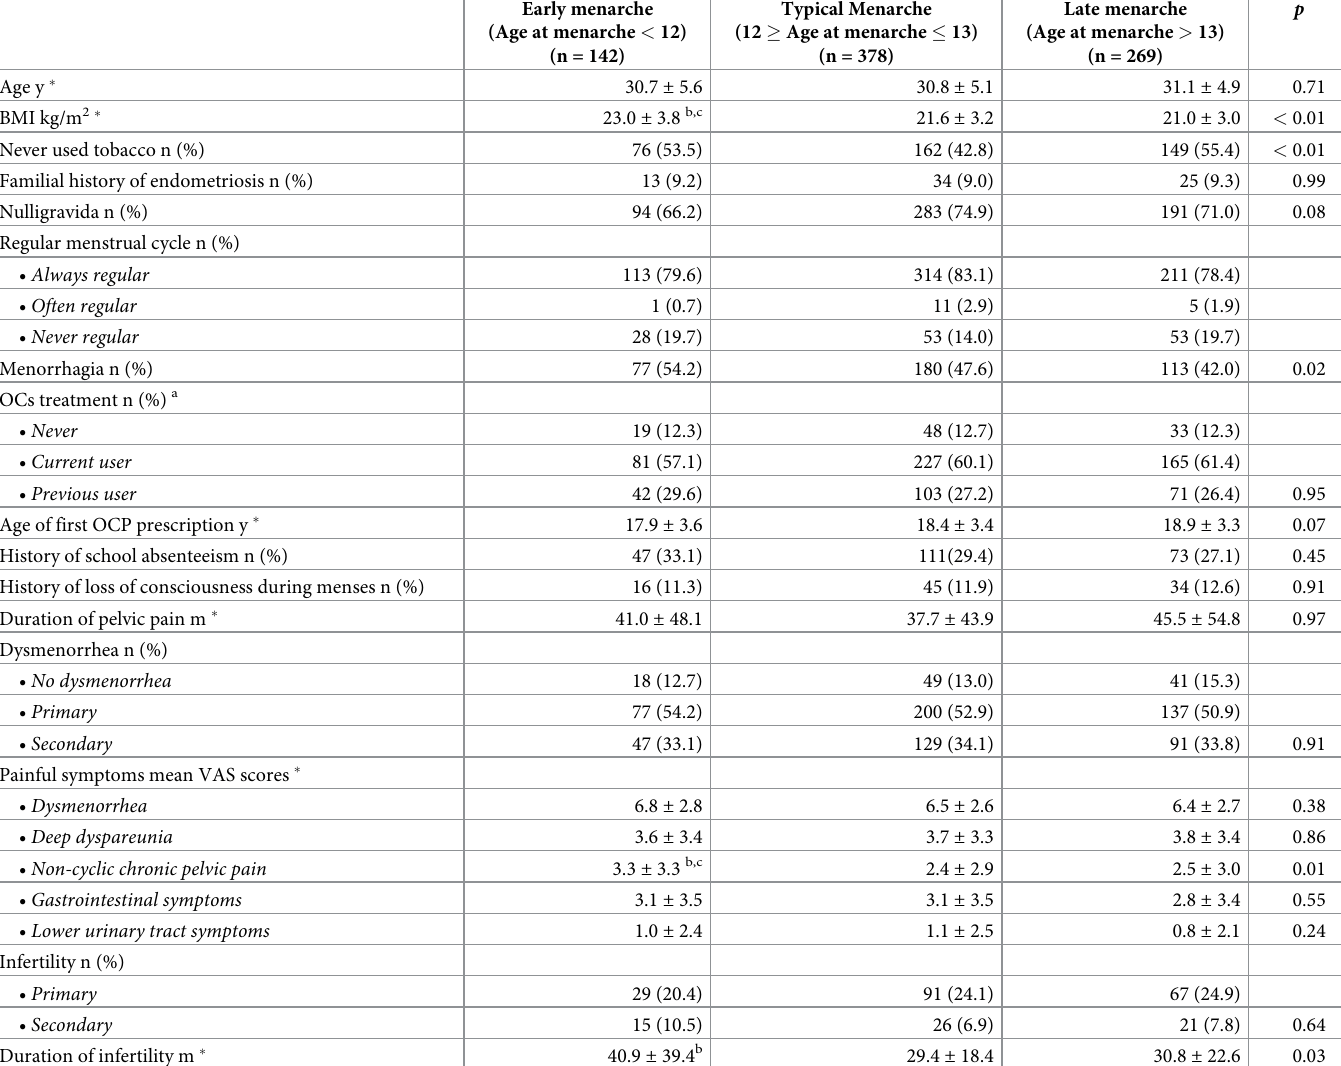
Table 1. Comparison of the menstrual cycle and the painful symptoms of 789 patients at first surgery for endometriosis, according to early, typical, and late menarche.